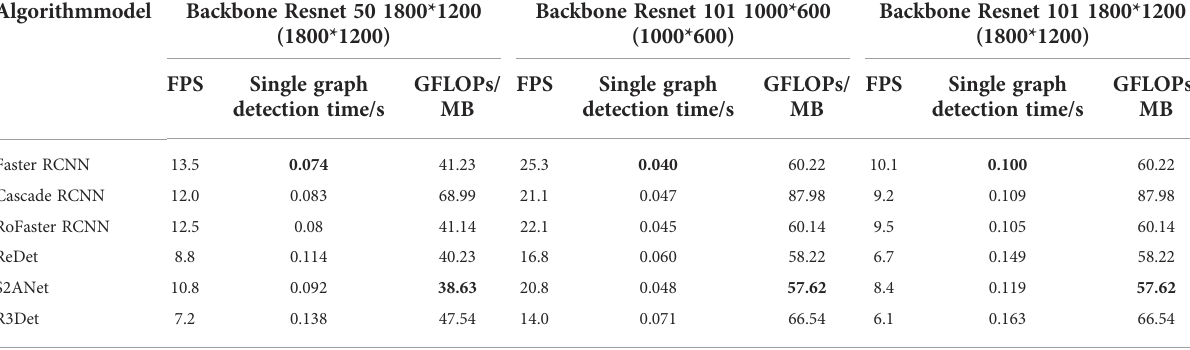
TABLE 6 Comparison of detection speed and parameter amount of the same backbone network algorithm.